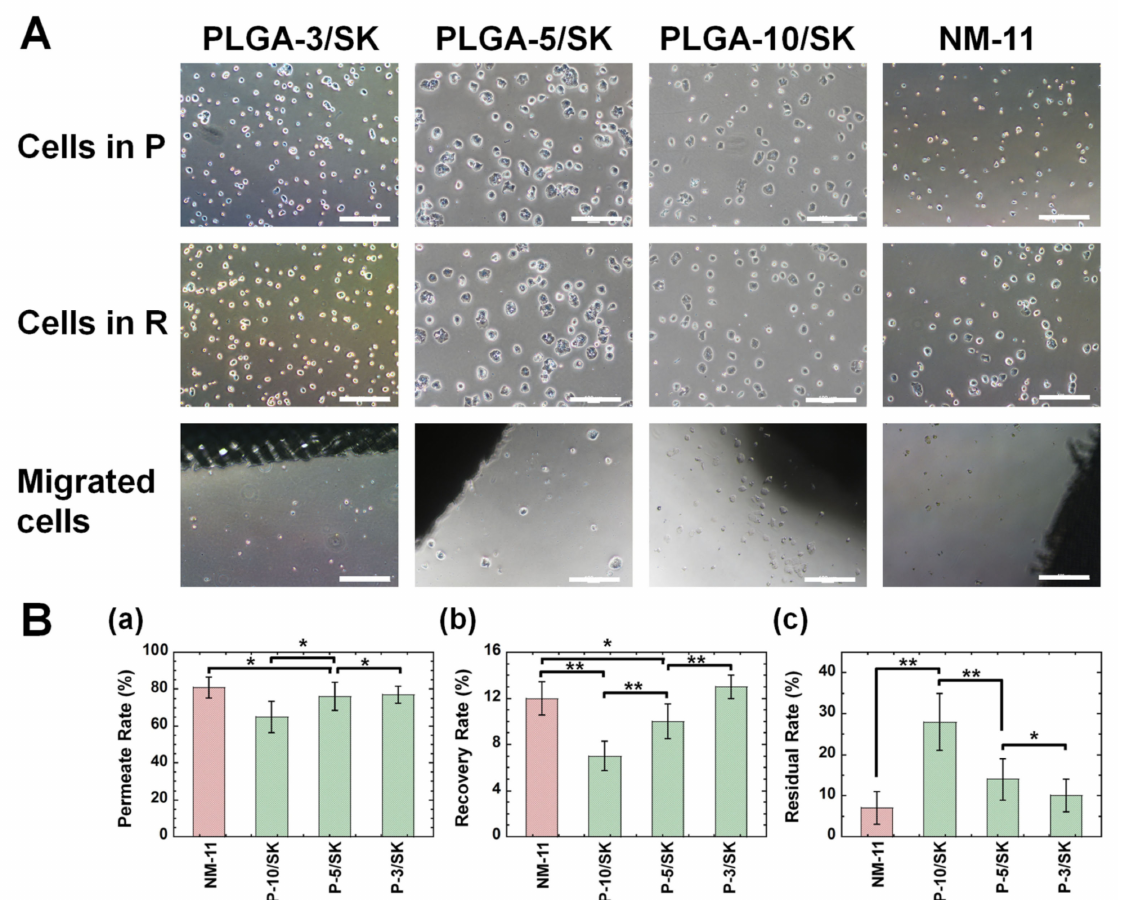
Figure 3. Morphologies and filtration characteristics of colon carcinoma cells after filtration from the filters. ( A ) Morpholo- gies of colon carcinoma (HT-29) cells in permeation solution (P) ( i – iv ), recovered solution (R) ( v – viii ), and migrated cell ( ix – xii ) morphologies via the PLGA-3/SK ( i , v , ix ), PLGA-5/SK ( ii , vi , x ), PLGA-10/SK ( iii , vii , xi ), and NM-11 ( iv , viii , xii ) filters. The scale bar indicates 500 µ m. ( B ) ( a ) Permeation rate of colon carcinoma (HT-29) cells via the NM-11, PLGA-10/SK (P-10/SK), PLGA-5/SK (P-5/SK), and PLGA-3/SK (P-3/SK) filters. ( b ) Recovery rate of colon carcinoma (HT-29) cells via the NM-11, PLGA-10/SK (P-10/SK), PLGA-5/SK (P-5/SK), and PLGA-3/SK (P-3/SK) filters. ( c ) Residual rate of colon carcinoma (HT-29) cells via the NM-11, PLGA-10/SK (P-10/SK), PLGA-5/SK (P-5/SK), and PLGA-3/SK (P-3/SK) filters. * p > 0.05, ** p <